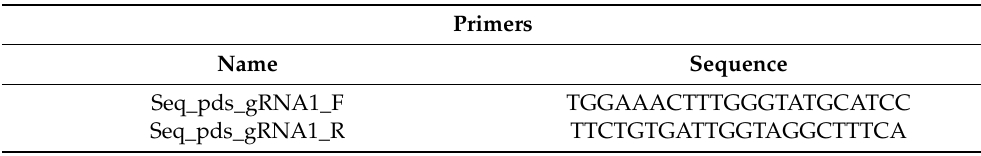
Table 2. Primers used for pds Sanger